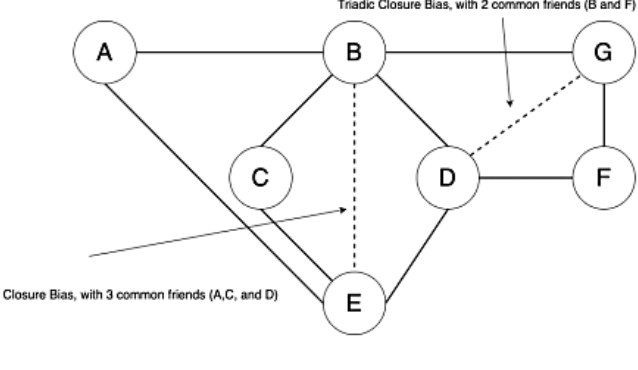
Figure 4. Triadic Closure